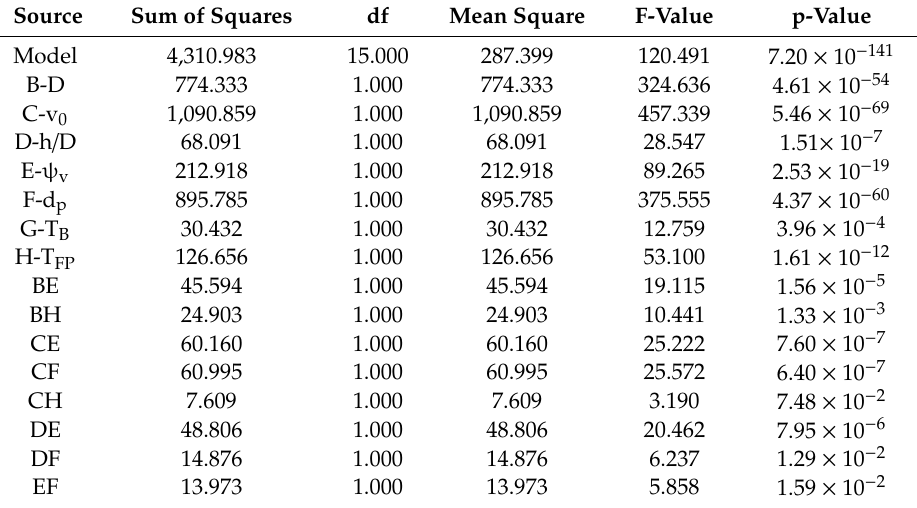
Table A4. Anova of modified 2-FI regression